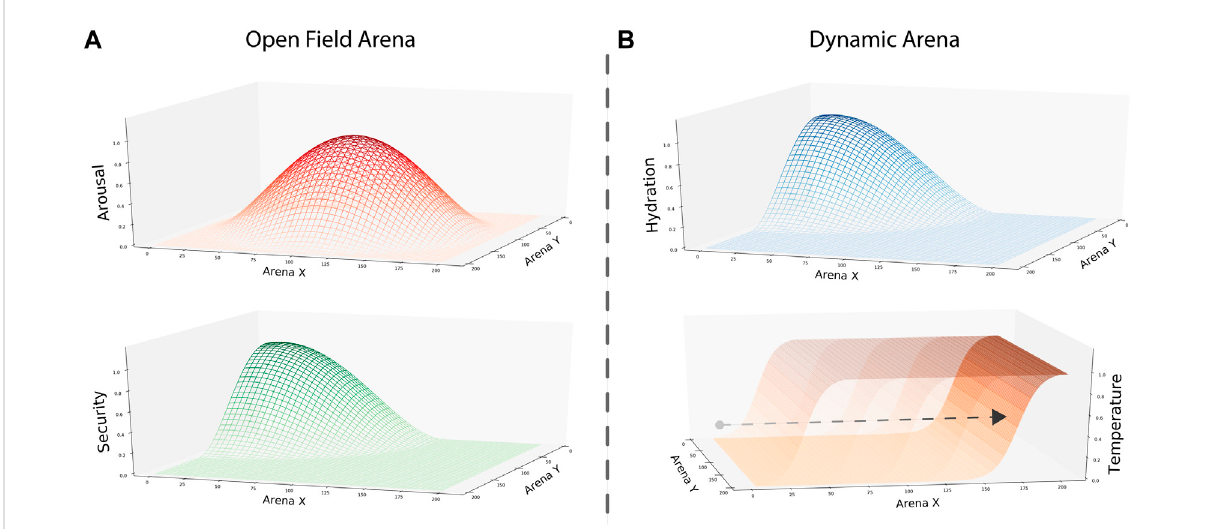
FIGURE 2 Gradients representing environmental opportunities to satisfy internal needs in each condition. (A) Arousal and security gradients were designedtoreplicaterodentbehaviorinanopen fi eldtest.Torepresentthemaximallevelofexposurewhenexploringthecenterofthearena,weset the peak of the gradient in that location. Similarly, we used the peak of the security gradient to represent the home base location in one of the corners. (B) Hydrationandtemperaturegradientsweredesignedtotesttheperformanceofourmodelinadynamicsetting.Here,thehydration gradient was static, with its peak in one of the corners. In contrast, the temperature gradient changed over time. To do so, we built the gradient as a two-dimensional sigmoidal function where its x -intercept increased as the simulation evolved. Thus, the peak area where internal temperature increases shrunk, and the intermediate area between gradients increased over